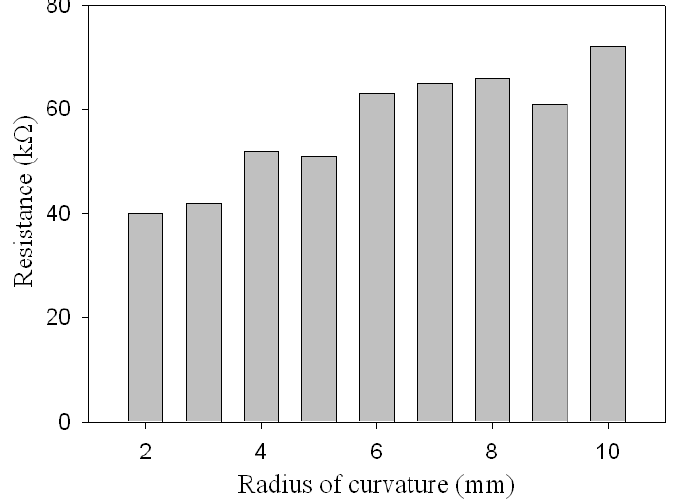
Figure 9. The measured resistance of the sensing composite increases with increasing bending radius of curvature.